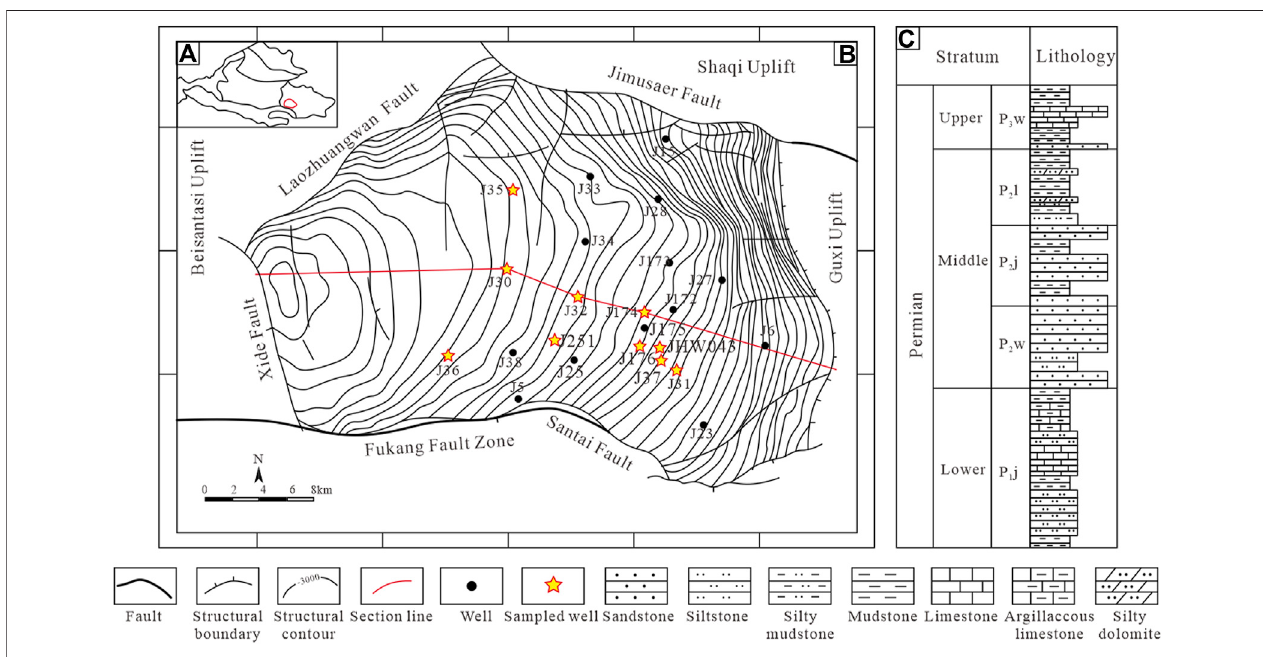
FIGURE 2 | Location (A) , Structural setting (B) and stratigraphic column (C) of Jimusar Sag. The middle Permian Lucaogou Formation (P2l) is the tight reservoir of this study.